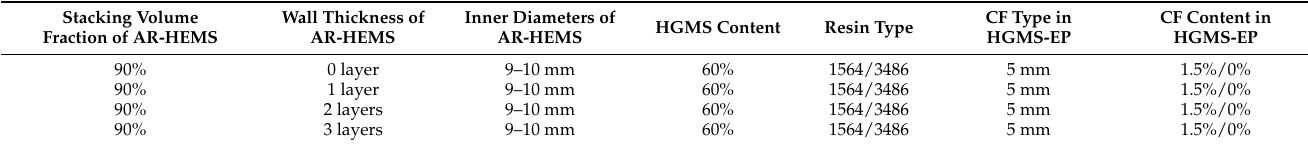
Table 2. Eight samples of ESF filled with AR-HEMS with different layers.